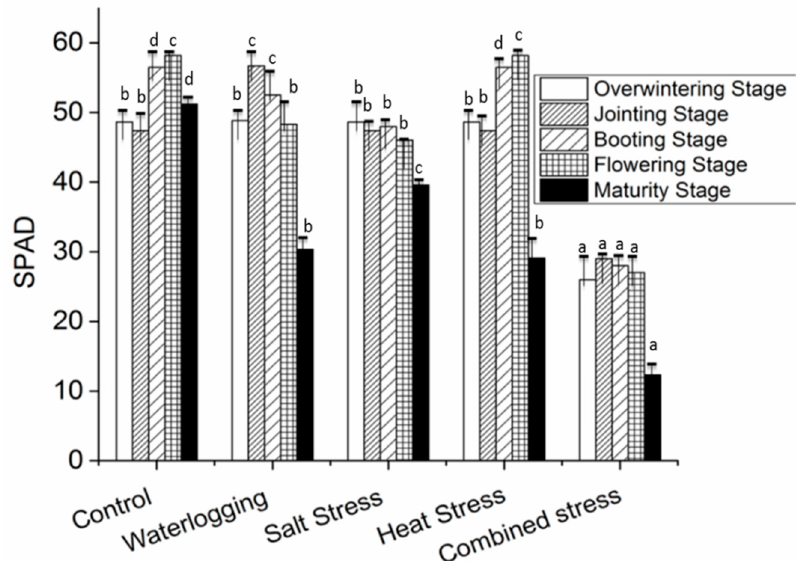
Figure 4. SPAD value of wheat plants during the five-stage growth of plants grown under different abiotic stresses. Reported values are the means and standard deviations of triplicates for each treatment. Note: sampling date at overwintering stage was 28 December 2020; at jointing stage was 12 March 2021; at booting stage was 30 March 2021; at the flowering stage was 17 April 2021; and at maturity stage was 28 May 2021. Lowercase letters show the significant differences among treatments according to one-way ANOVA and DMRT, while the significance level was p ≤ 0.05.